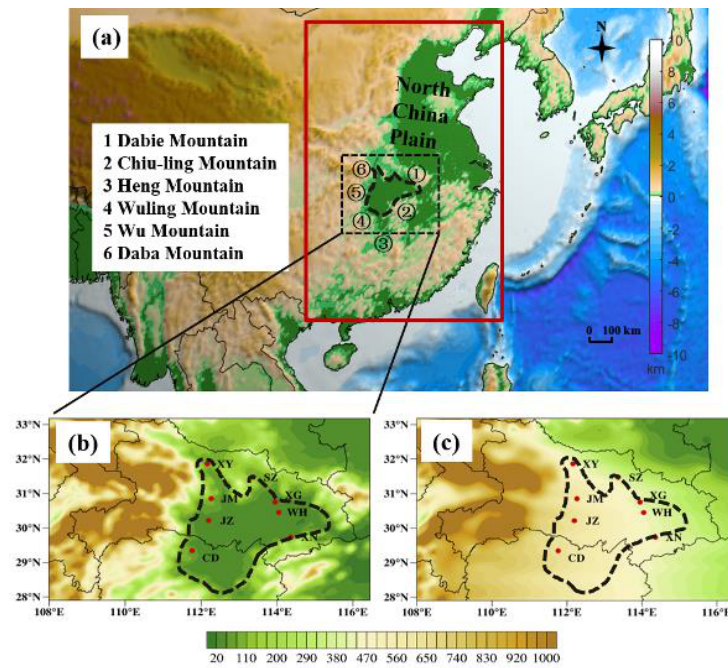
Figure 1. ( a ) The geographical location of the THB surround by six mountains over China [36] with the red frame covering the WRF-Chem simulation domain; ( b ) the terrain heights and the locations of Xiangyang (XY), Jingmen (JM), Jingzhou (JZ), Changde (CD), Suizhou (SZ), Xiaogan (XG), Wuhan (WH), and Xianning (XN) with the black dash line indicating the lower lands (mainly less than 200 m a.s.l.) around the THB; ( c ) the filled THB using the method of Zhang et al., 2018